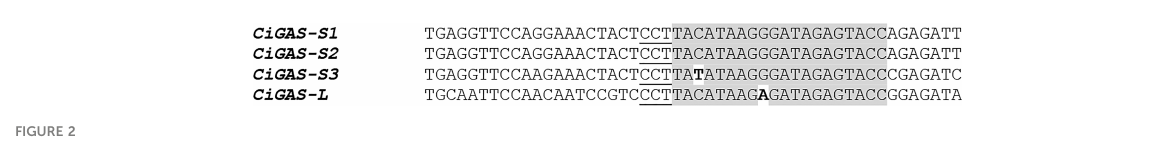
FIGURE 2 Alignments of the genomic sequences of the four CiGAS genes at the target site in exon 4. The target region of the sgRNA is highlighted in grey. The PAM is underlined, and the mismatches on CiGAS-S3 and CiGAS-L are in